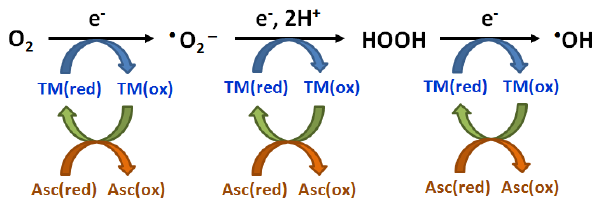
Fig. 1. Transition-metal-catalyzed production of reactive oxygen species. TM represents transition metals, Asc is ascorbate, and (red) and (ox) represent reduced and oxidized forms. In this scheme, re- duced forms of transition metals donate electrons to convert dis- solved molecular oxygen to, sequentially, superoxide, hydrogen peroxide, and hydroxyl radical, with the reductant ascorbate (Asc) serving as the ultimate electron